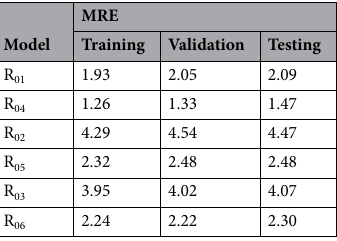
Table 6. MRE (%) attained for the regression models.